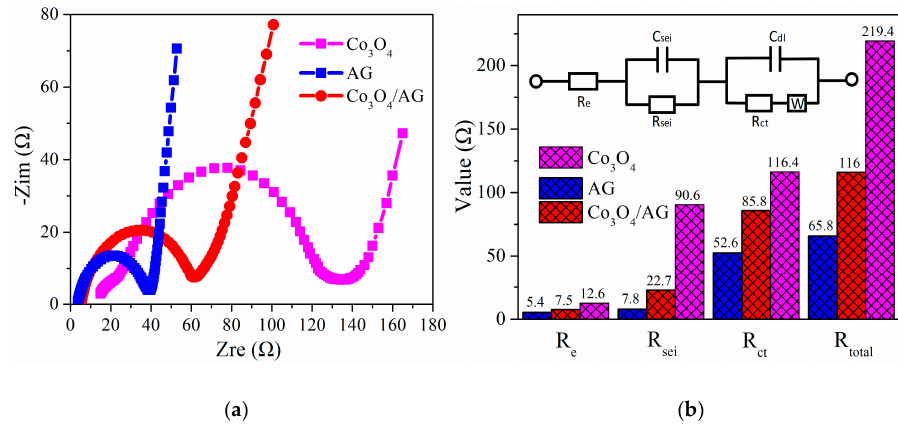
Figure 8. Electrochemical impedance spectroscopy (EIS) behavior of samples: ( a ) Nyquist plots and ( b ) the values of R e , R sei , R ct , and R total simulated by the equivalent circuit for Co 3 O 4 , AG, and the Co 3 O 4 /AG nanocomposite (inset: the whole equivalent circuit for anode materials).